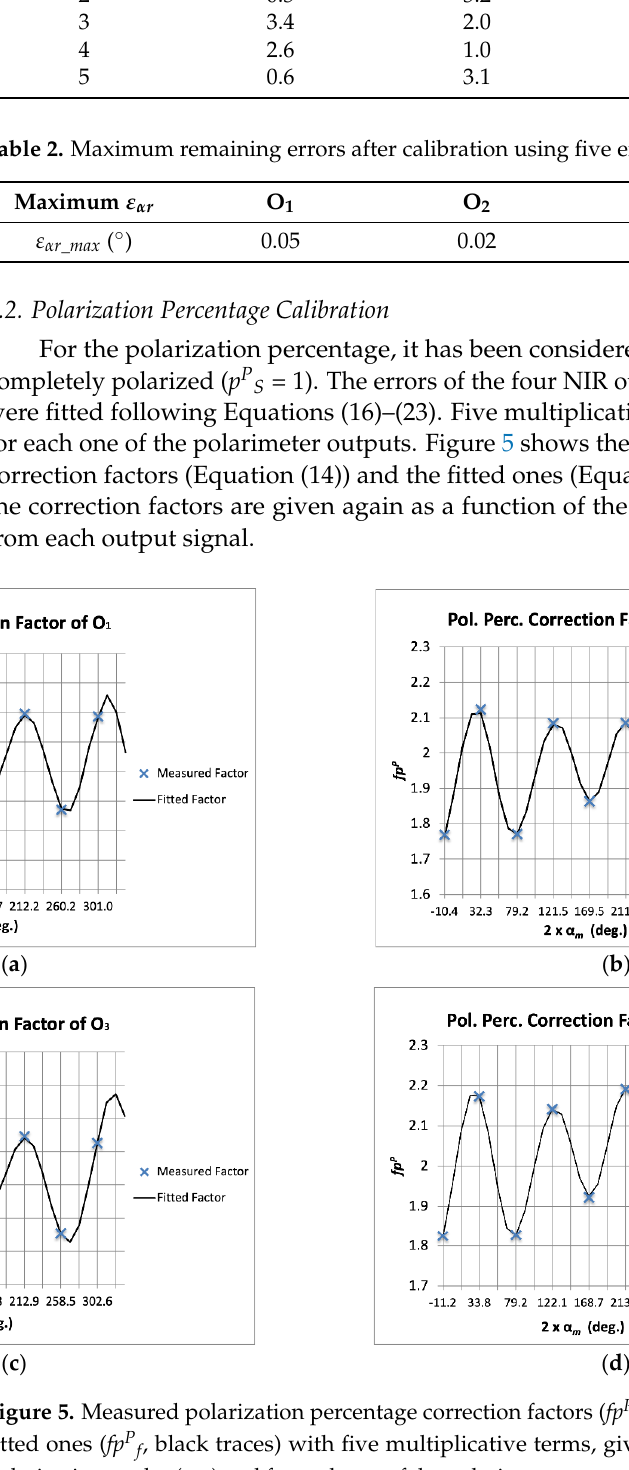
Table 1. Fitting parameters K i for each error term and polarimeter output.